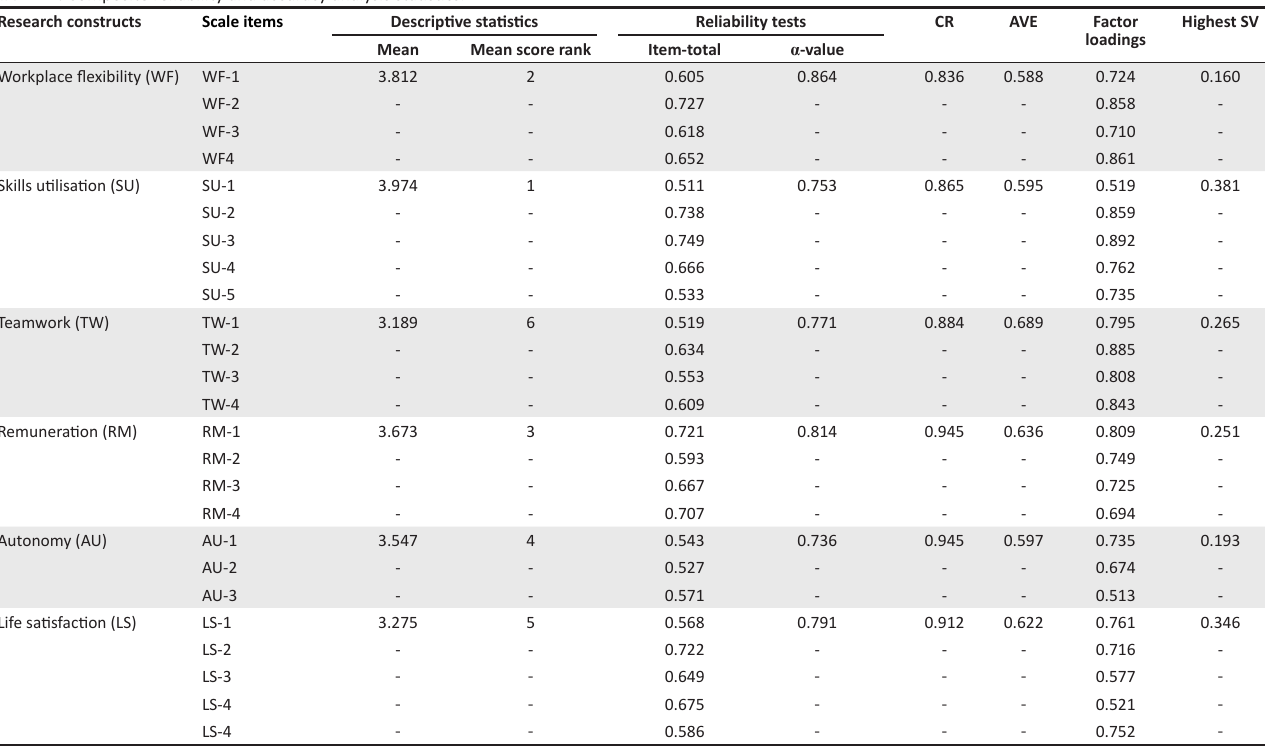
TABLE 2: Composite reliability and accuracy analysis statistics. Research constructs